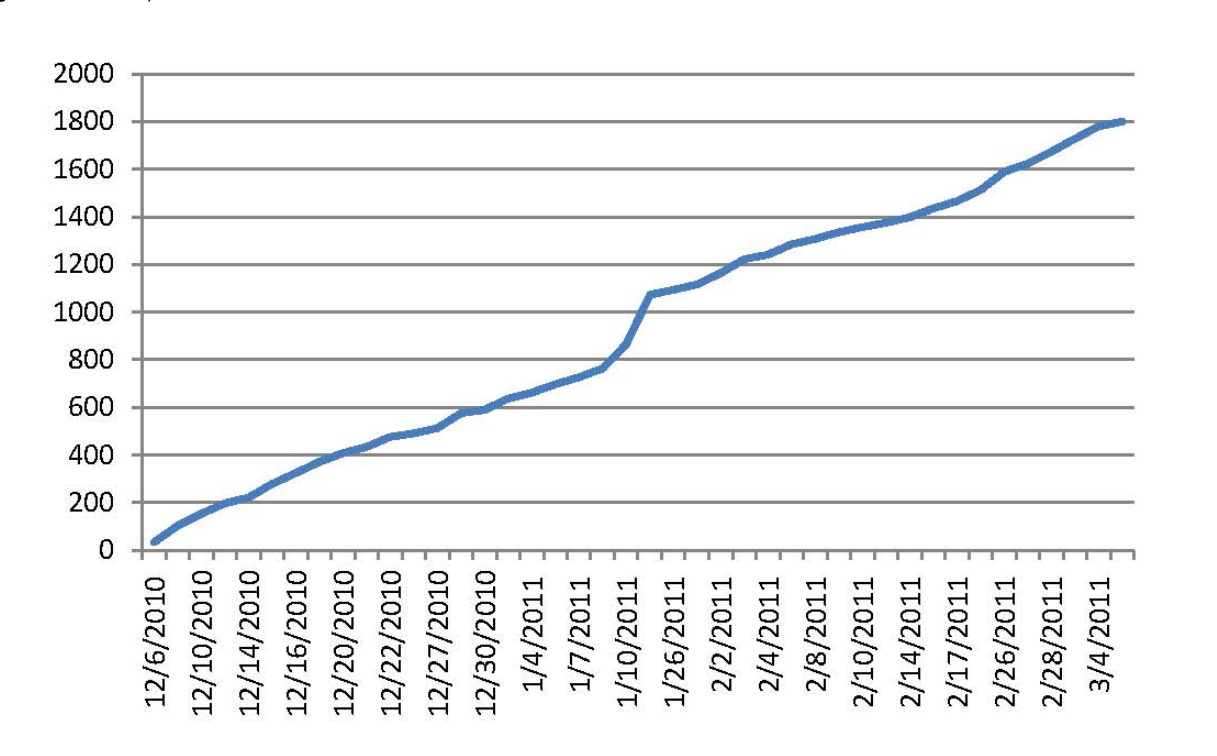
Figure 2. Baseline patient